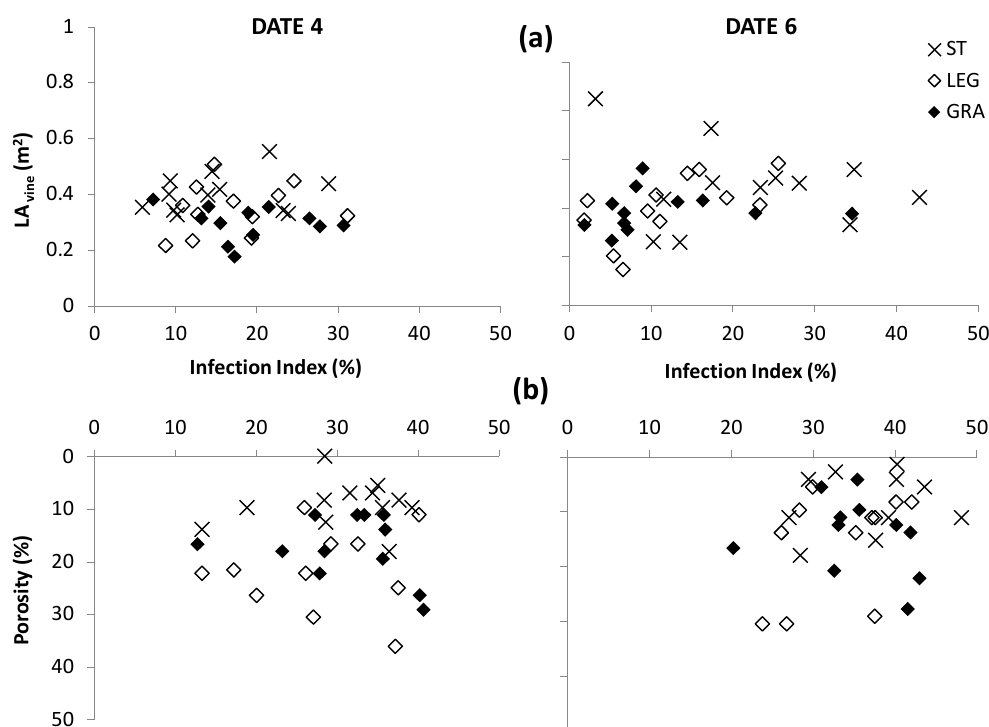
Figure 7. Relationship between the downy mildew infection index and total LA per vine ( a ) and canopy porosity ( b ) during disease observation dates 4 and 6 in the canopy wall, for the three-season study period.